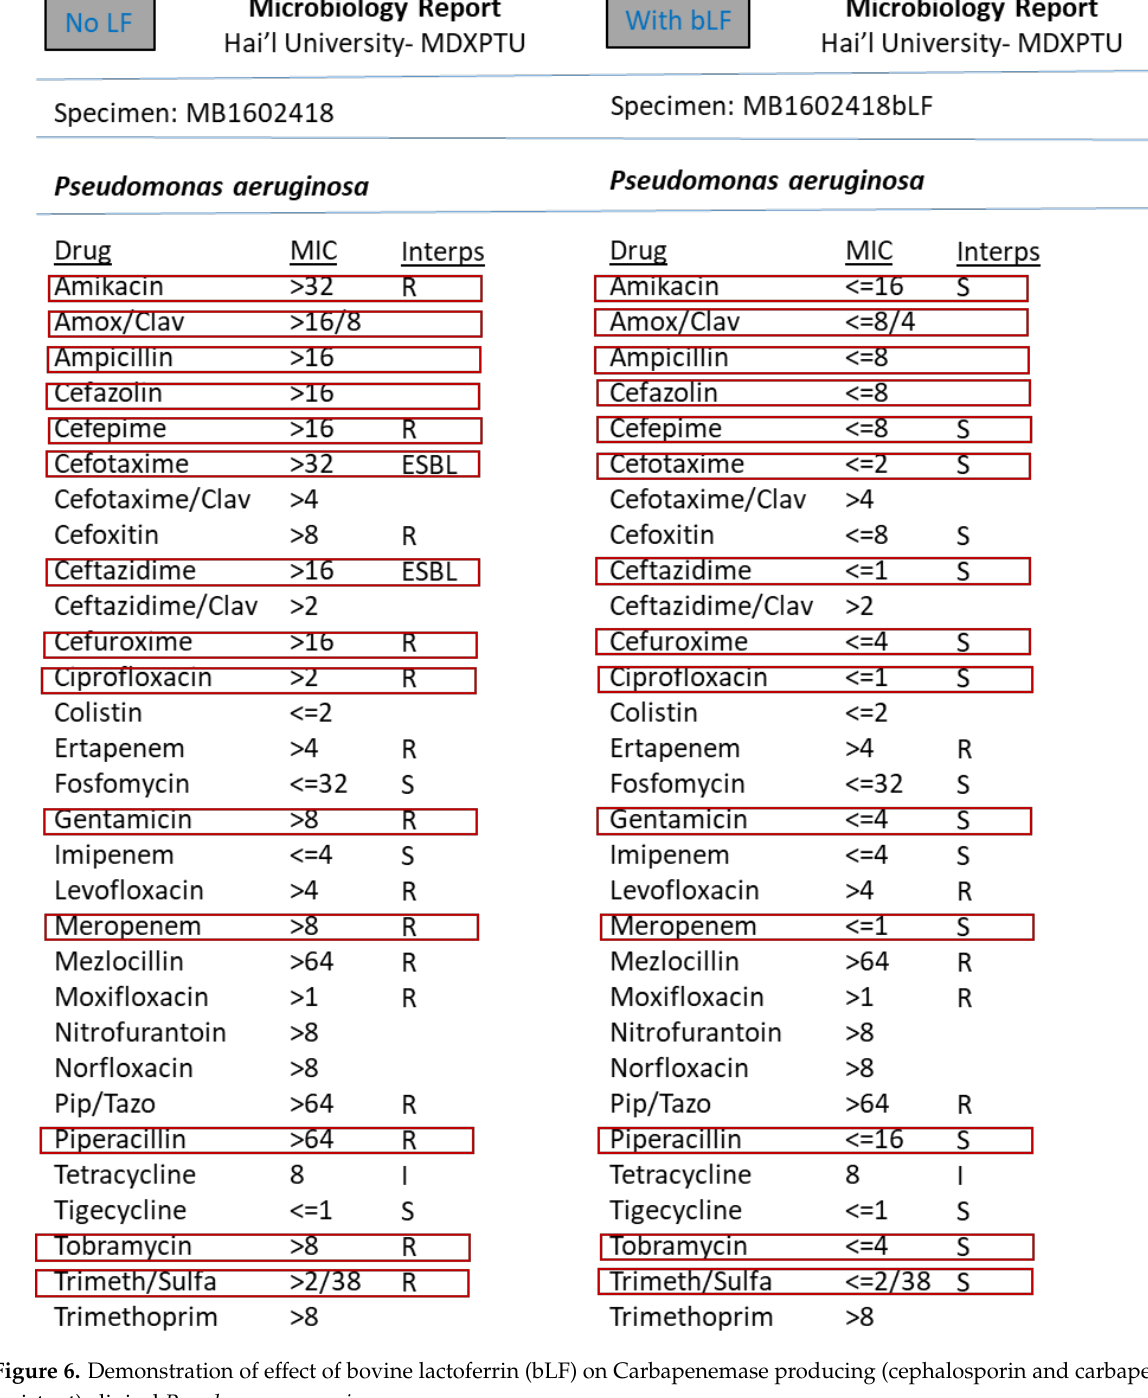
Figure 6. Demonstration of effect of bovine lactoferrin (bLF) on carbapenemase producing (cephalosporin and carbapenem resistant) clinical Pseudomonas aeruginosa